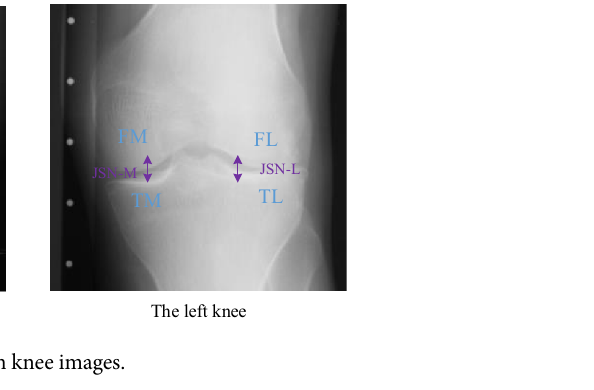
Figure 1. The specific features in knee